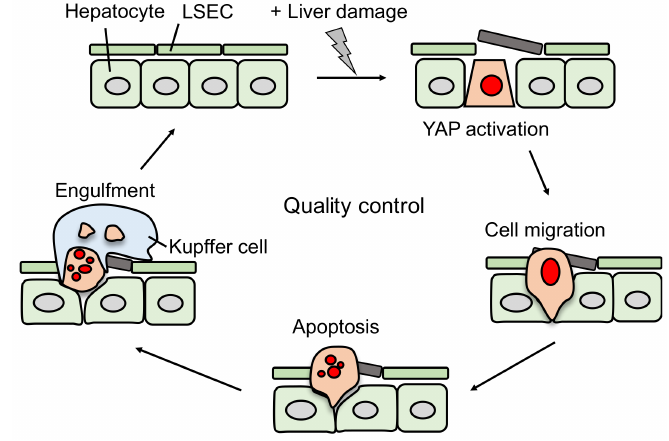
Figure 3. Model of YAP-induced damaged hepatocyte elimination. Hepatocytes expressing activated YAP in the presence of liver injury such as ethanol migrate into sinusoids, undergo apoptosis, and are engulfed by Kupffer